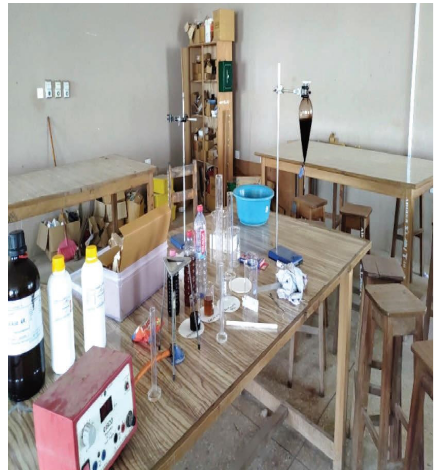
Figure 2: Dehydration of WCLO. Figure 3: Laboratory apparatus for WCLO